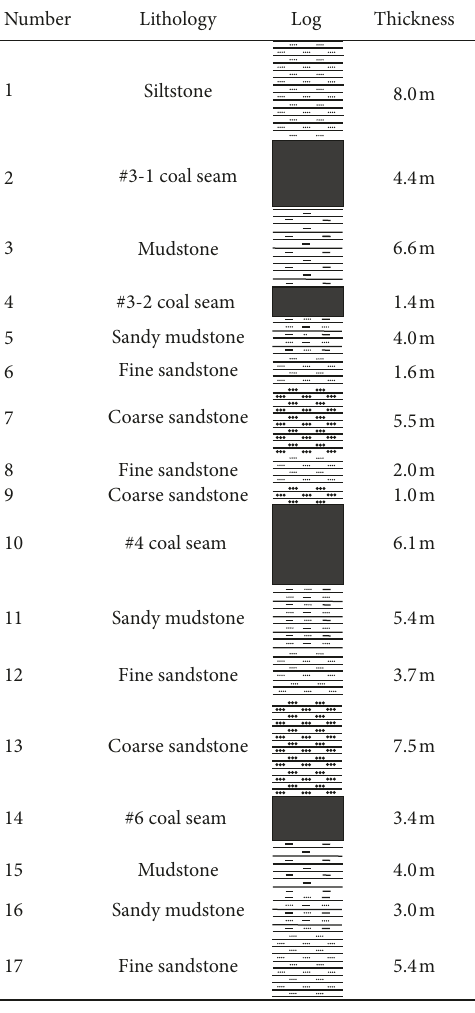
Figure 4: Stratigraphic column of borehole YZK2102 in 6105 longwall working face.